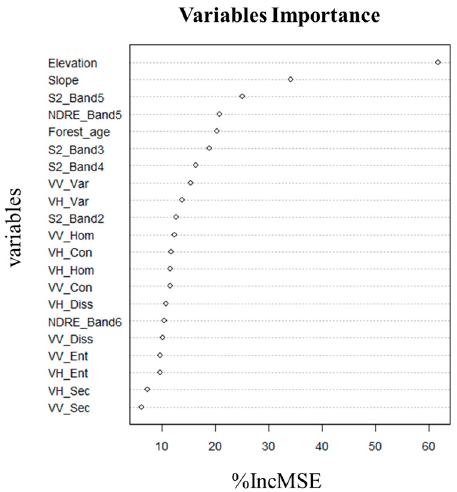
Figure 7. Importance assessment based on %IncMse in the RF model.